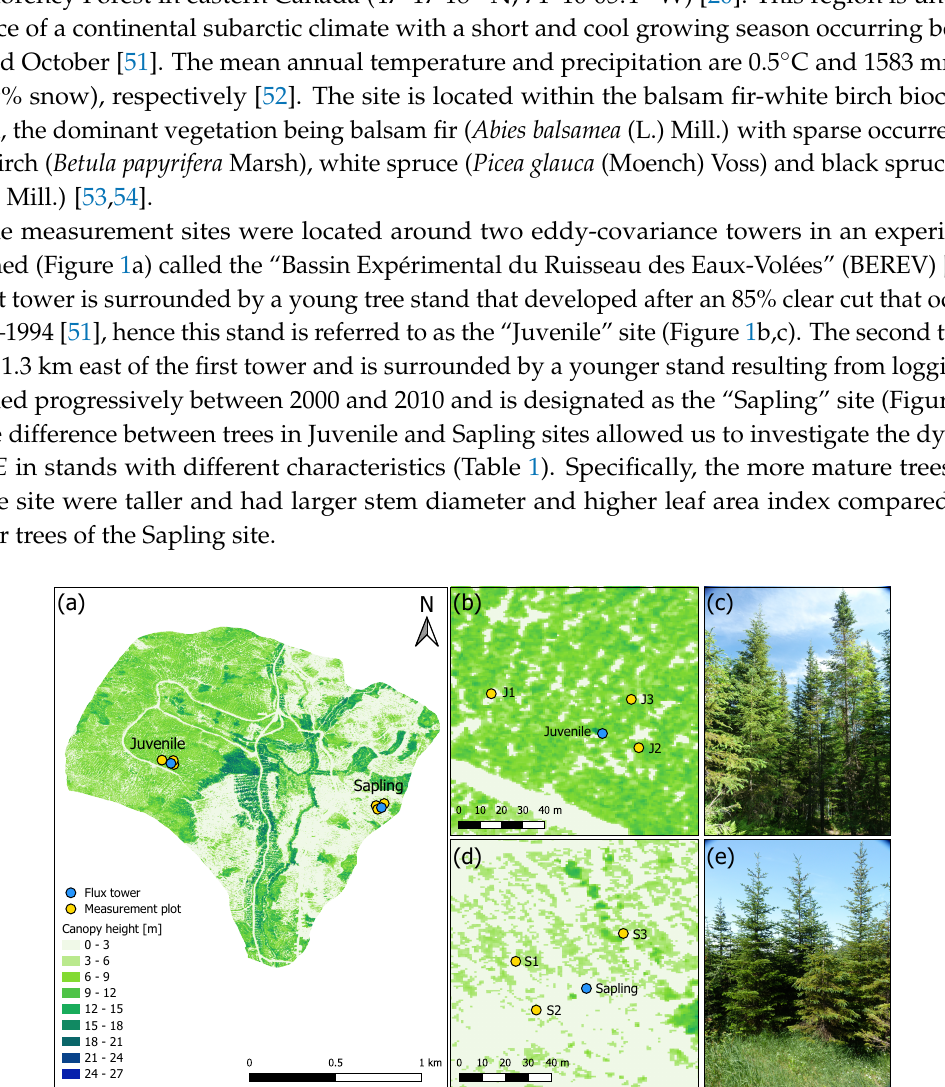
Figure 1. ( a ) Location of Juvenile and Sapling flux towers in the experimental watershed; ( b ) location of measurement plots around Juvenile flux tower; ( c ) trees at the Juvenile site; ( d ) location of measurement plots around Sapling flux tower; and ( e ) trees at the Sapling site. Vegetation heights are computed from LiDAR surveys (Source: Ministère des Forêts, de la Faune et des Parcs du Québec) collected in